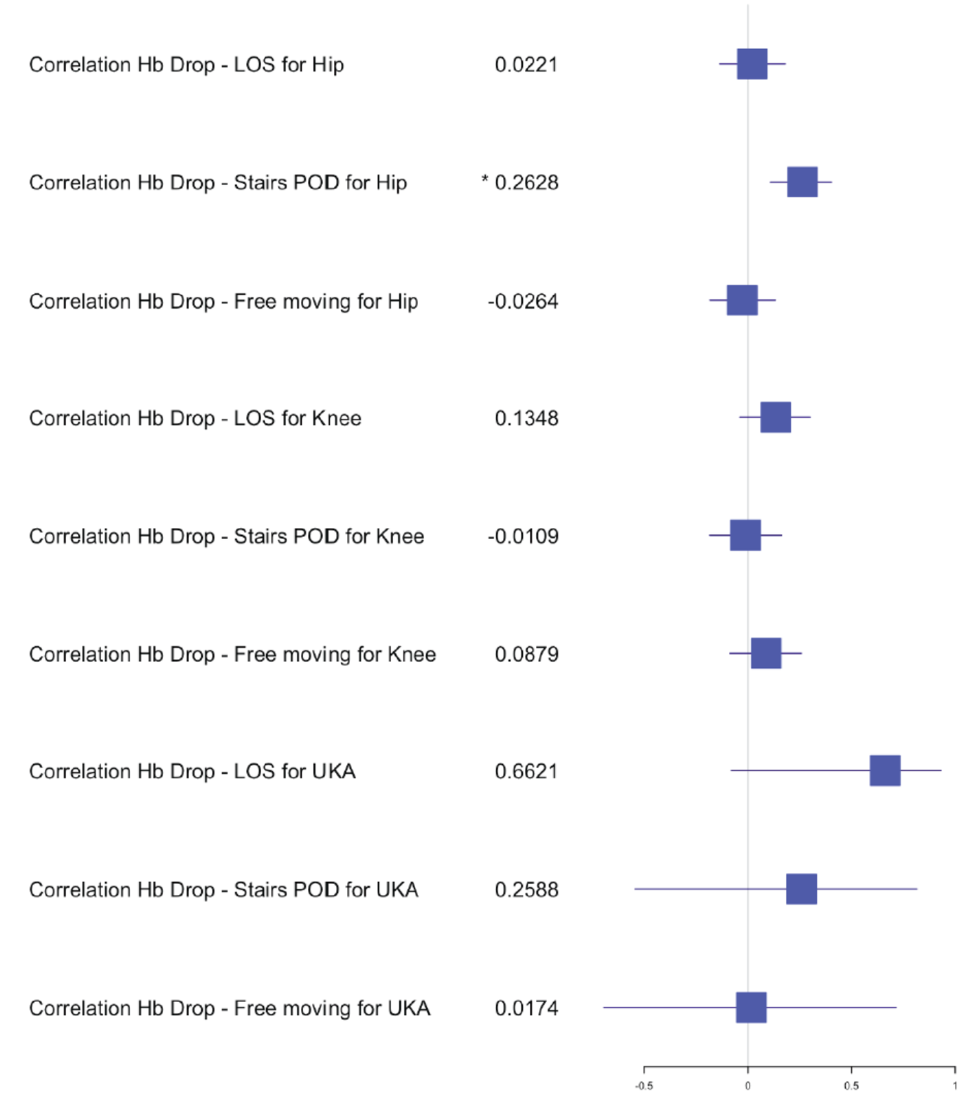
Figure 6. Forest plot of the effects of Hb drop on LOS and functional outcome for staged arthroplasty. (*) significant results.